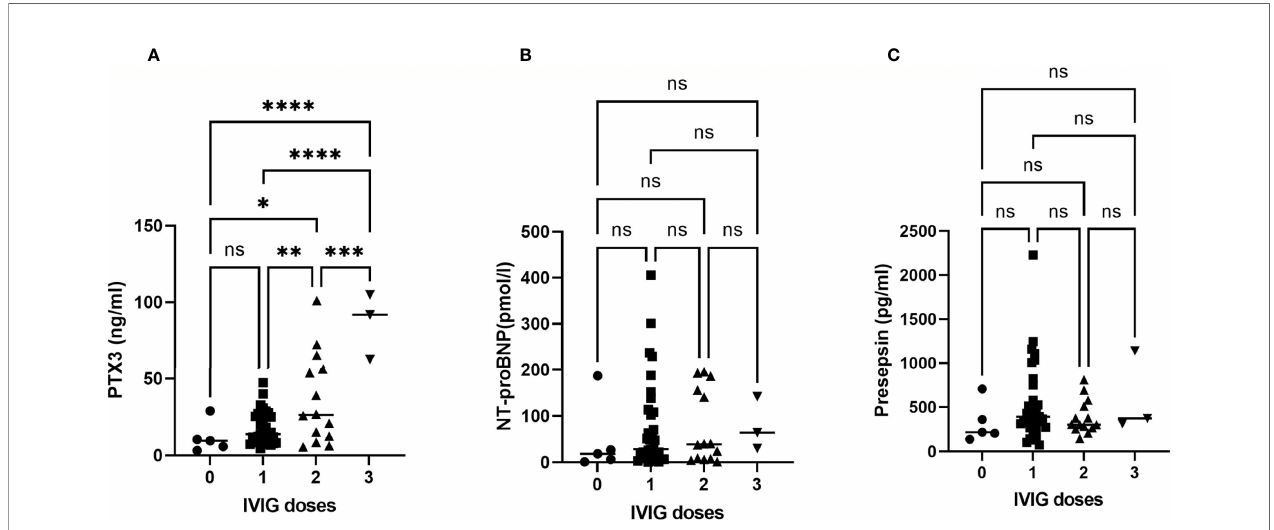
FIGURE 2 | Correlation curve showing the dose of IVIG needed to resolve KD versus PTX3, NT-proBNP and Presepsin levels. The plasma PTX3 (A) , NT-proBNP (B) and Presepsin (C) levels are plotted against the dose of IVIG needed to resolve the KD. Zero indicates cases treated with aspirin only (non-IVIG). The PTX3 levels exhibited a signi fi cant correlation with IVIG doses required to resolve KD (y = 22.177 x - 4.2684, R² = 0.6402). ns, not signi fi cant; * p < 0.05, ** p < 0.01, *** p < 0.005, **** p < 0.001.